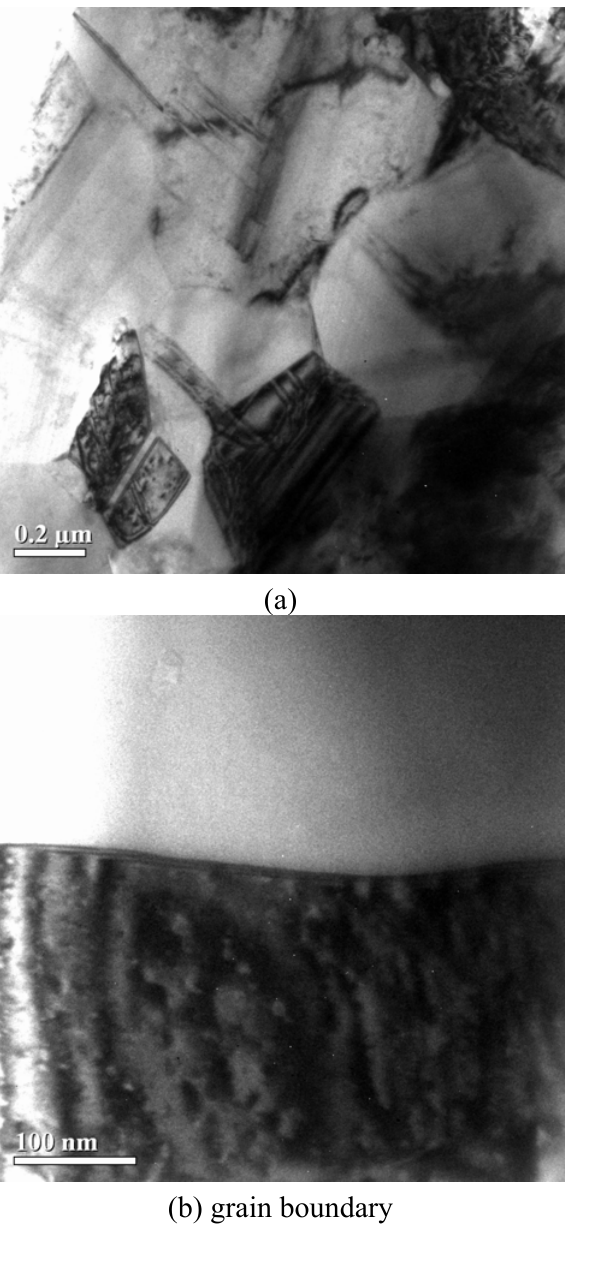
Figure 4. Schematic of nanoparticles insertion into the grain body during sintering.